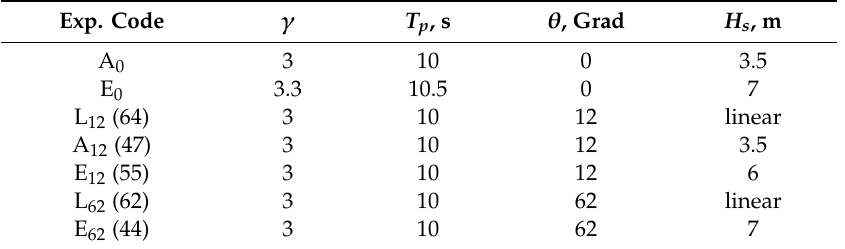
Table 1. Parameters of the numerical